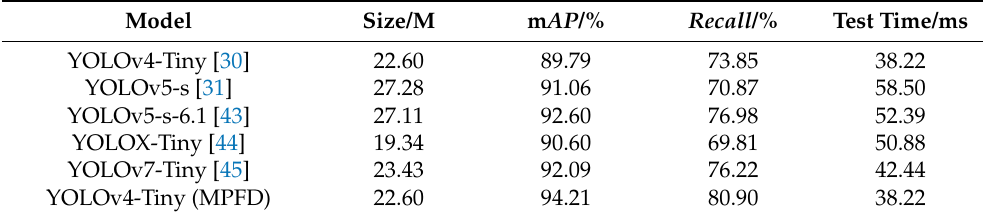
Table 5. Performance of lightweight